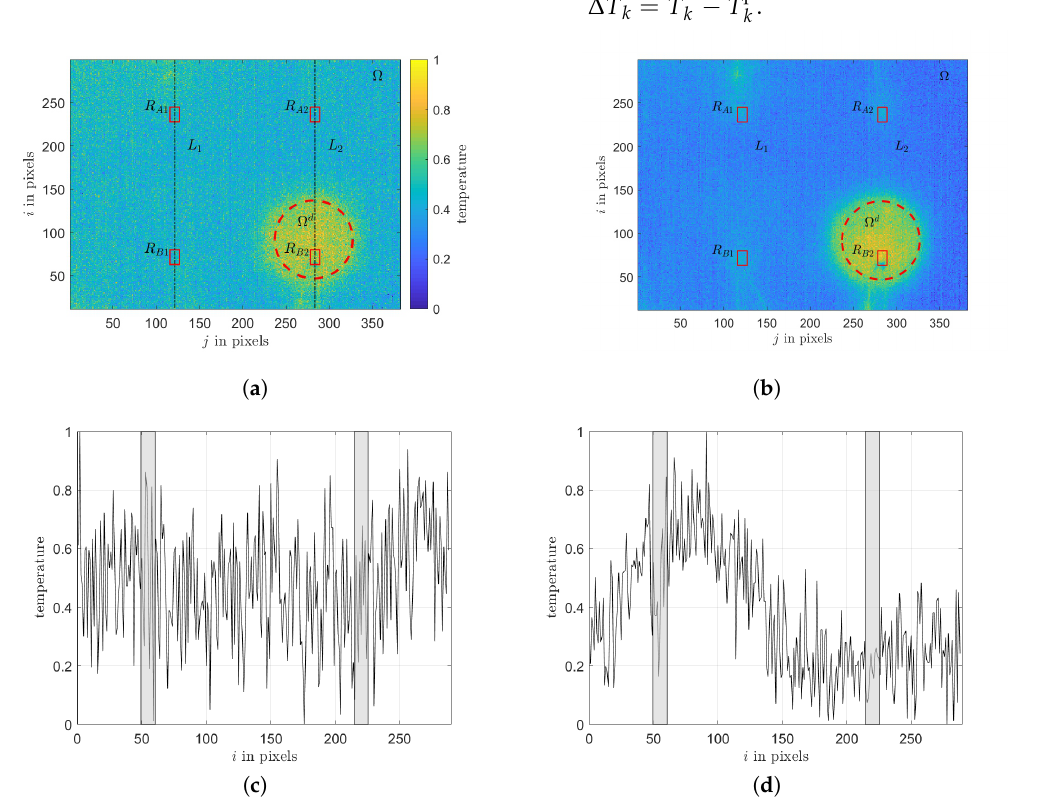
Figure 7. ( a ) Temperature difference ∆ T k of five consecutive images before excitation and five consecutive IR-images at the end of the excitation sequence. ( b ) Thermography results of the principal component analysis (PCA)-based feature extraction algorithm. ( c ) Normalized temperature difference profile with respect to the pixel-line L 1 , whereas ( d ) shows the profile with respect to the pixel-line L 2 . In both temperature profiles the gray shaded areas indicate the location of the surface temperature